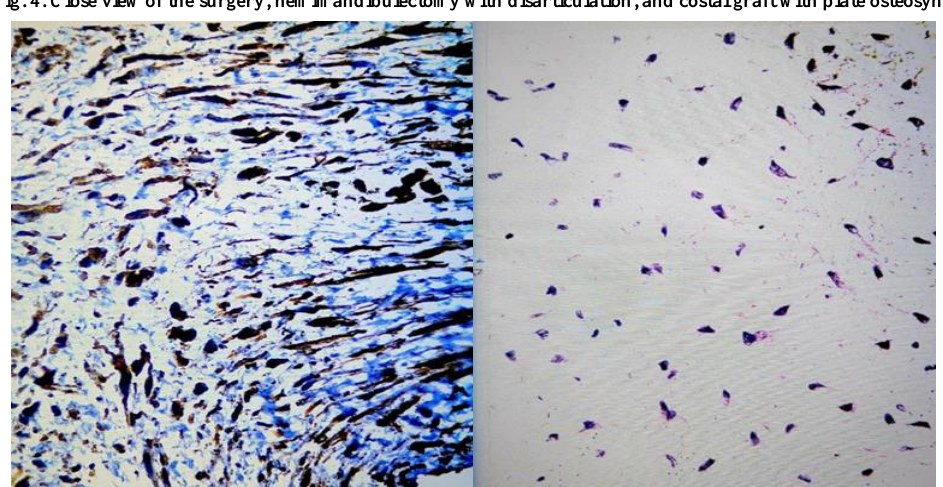
Fig. 5. Immunohistochemically reported tumor cells negative for S-100 discarding neurofibroma and positive for Vimentin. Left, Vimentin (400X). Right, S-100 (400X).